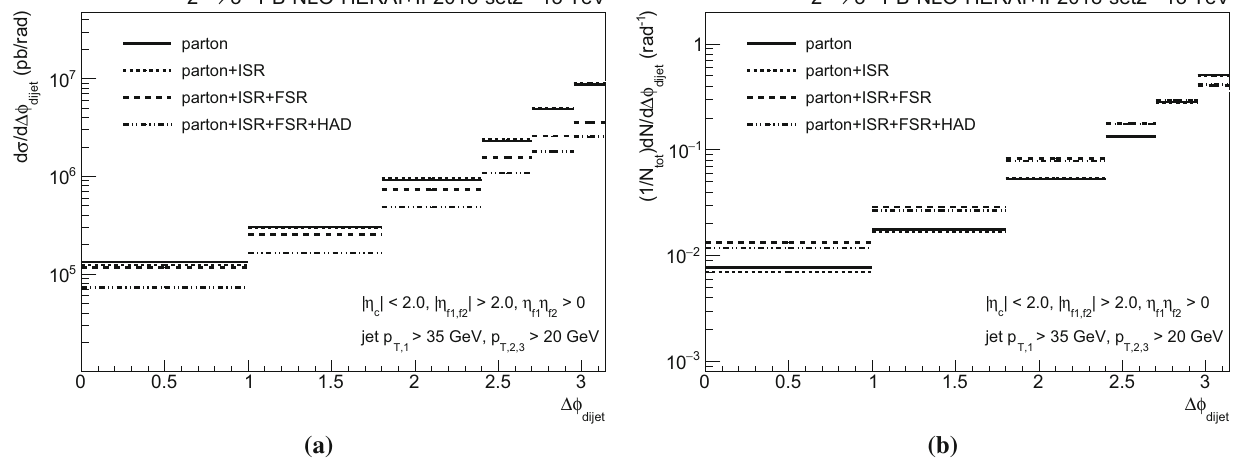
tions. Shown in absolute cross sections ( a ) and normalised distributions ( b ). The bottom panel shows the ratio of the 2 → 3 over 2 → 2 pre- dictions to illustrate the change in cross